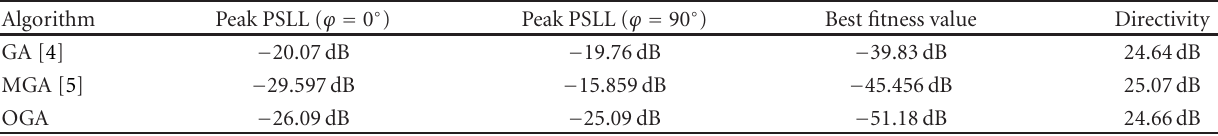
Table 5: Comparison with the GA [4] and MGA [5] for the planar array.